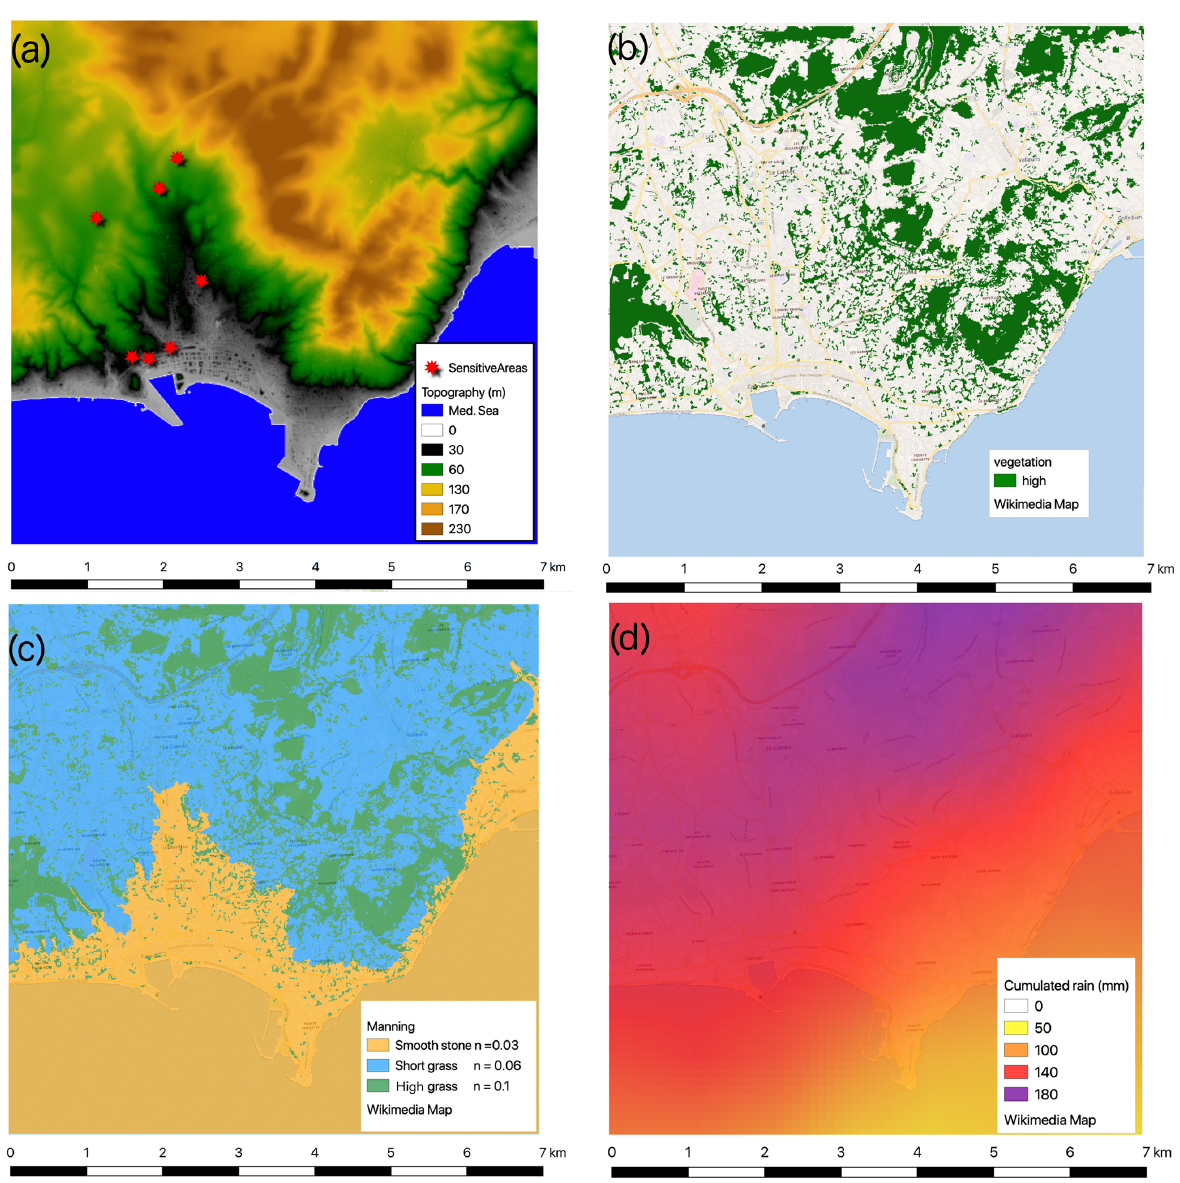
Figure 17. (a) Topography of the simulated domain and position of sensitive areas. (b) High-vegetation zone. (c) Manning coefficient values. (d) Accumulated rain during the rain